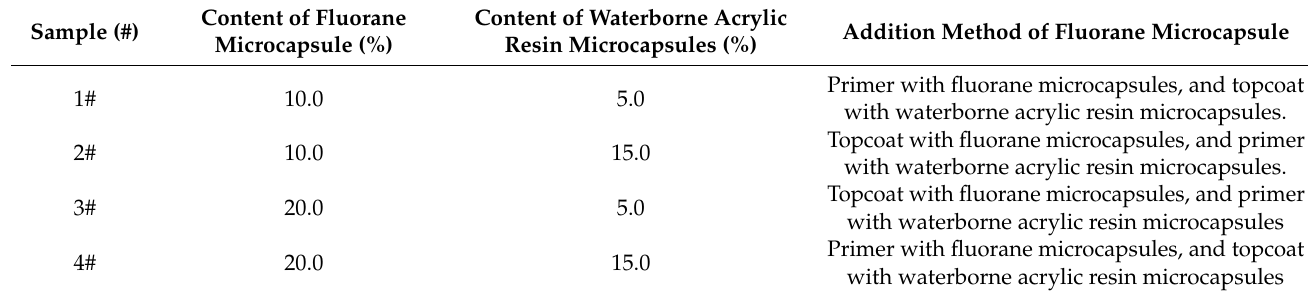
Table 2. The orthogonal experimental test of discoloration and self-repairing film.